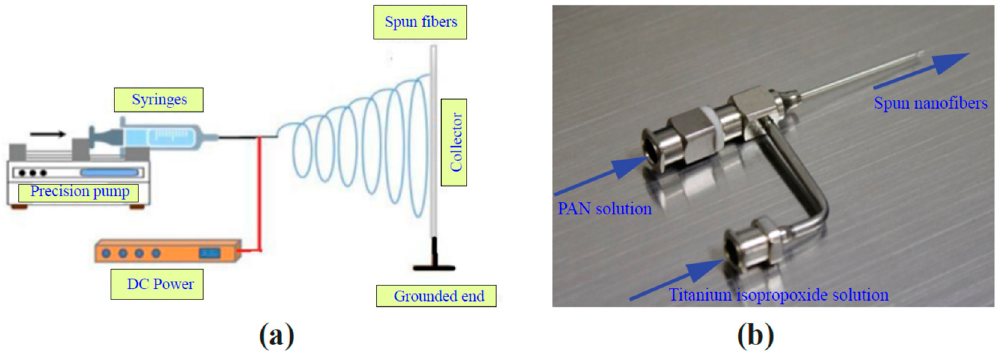
Figure 1. Equipment layout of the reaction spinning process: ( a ) schematic of the reaction spinning; ( b ) photograph of the co-axial spinneret for the reaction spinning.